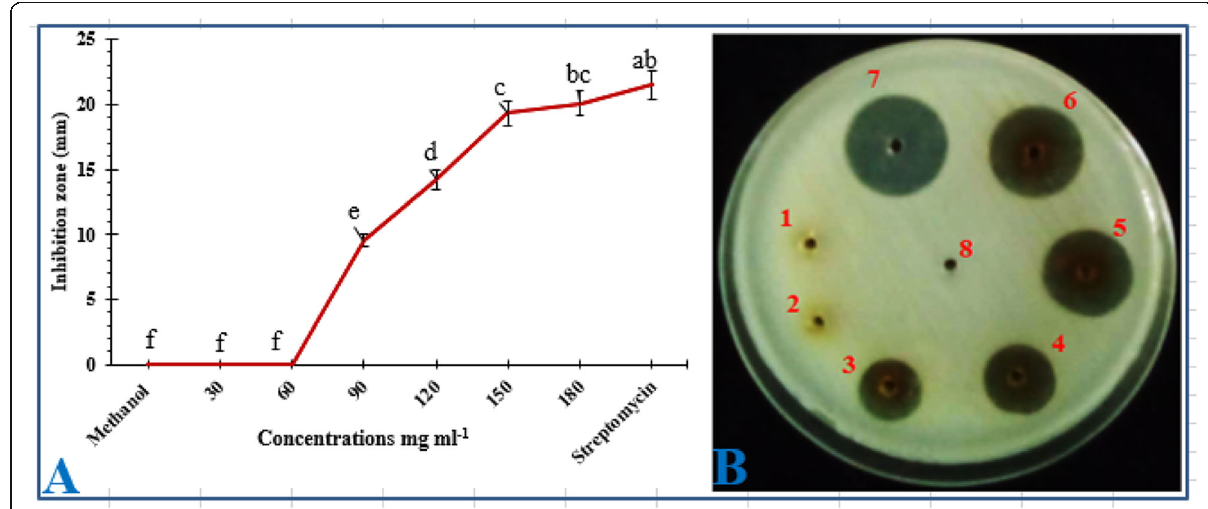
Fig. 1 Antibacterial potential of fungal metabolites against R. solanacearum . a Graphical presentation of data regarding zone of inhibition (ZI) produced by different concentrations of fungal metabolites. b Nutrient agar plate showing ZI, 1: 30 mg/ml, 2: 60 mg/ml, 3: 90 mg/ml, 4: 120 mg/ ml, 5: 150 mg/ml, 6: 180 mg/ml, 7: Streptomycin, and 8: